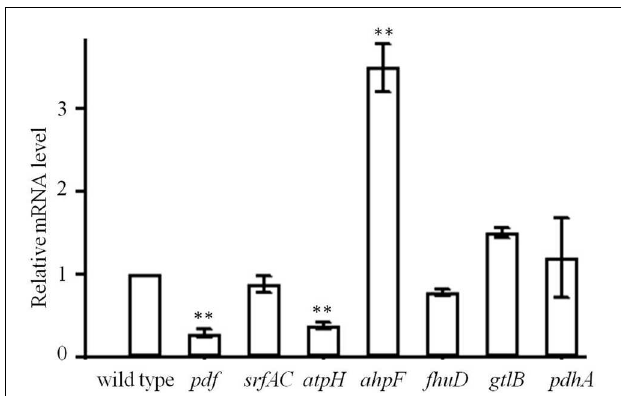
FIGURE 6 | Trancription level of pdf, srfAC, atpH, ahpF, fhuD, gtlB, and pdhA in the mutant of V. anguillarum . Wild type was used as a control. Values reported are the mean of three replicates. Error bars indicate the standard deviation. ∗∗ p < 0.01 was taken to indicate statistical distinct